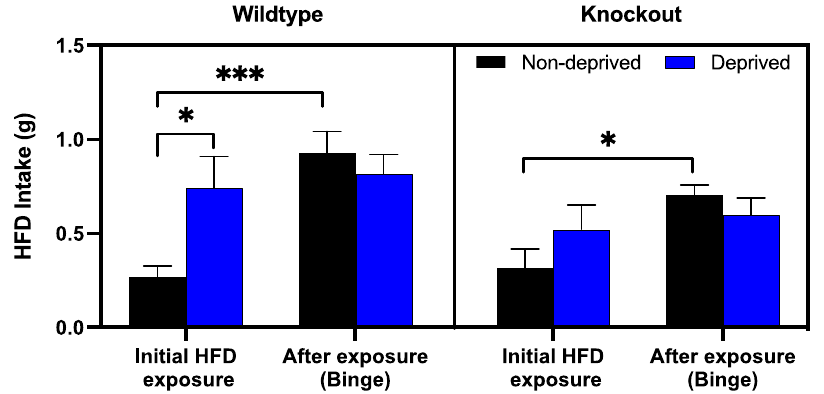
Figure 5. HFD consumption in non-deprived and deprived beta-endorphin knockout mice and their wildtype littermates/controls during the test for binge-eating. Food intake (g) was measured in non-deprived and deprived mice exposed to HFD for one hour and compared to their initial HFD intake, as measured in Figures 2 (deprived group) and 3 (non-deprived group). All data are expressed as mean ± SEM of 6-9 mice per group. * p < 0.05; *** p < 0.0001, mixed-effect analysis/Fisher’s LSD.